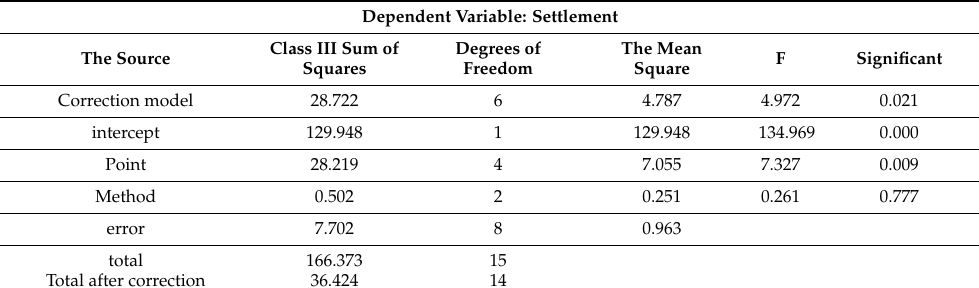
Table 3. Inter-subject effect test.